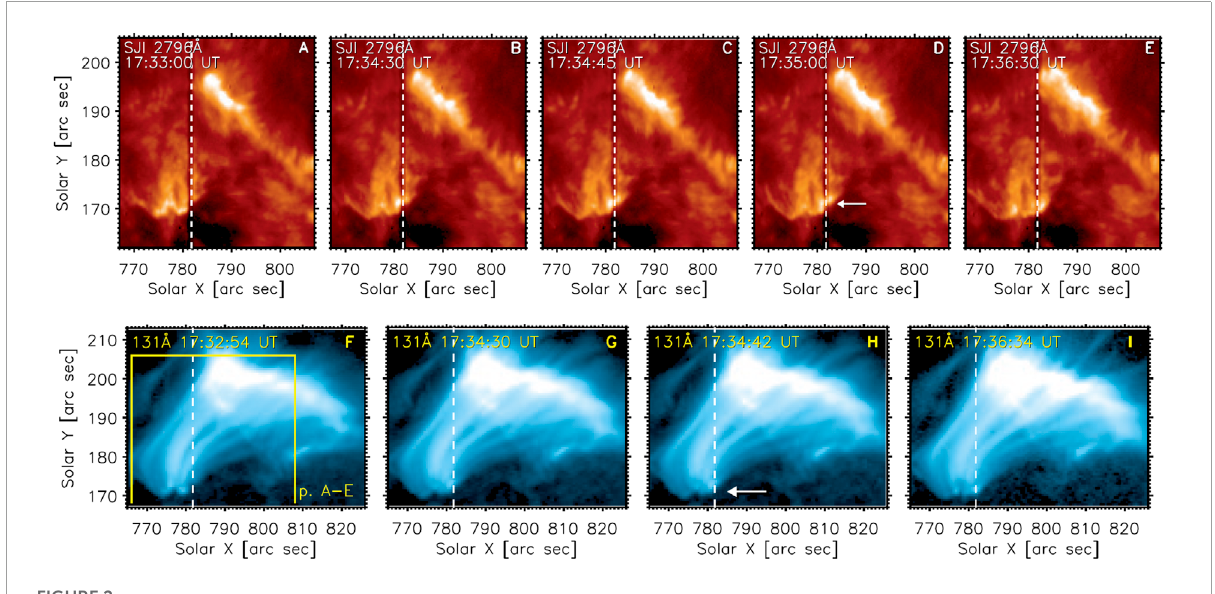
FIGURE 2 A pair of flare ribbons [panels (A–E) ] and an arcade flare loops [panels (F–I) ] observed in the SJI 2796Å and AIA 131Å during the impulsive phase of the flare. White dashed line marks the position of the IRIS slit at 17:35 UT. The white arrow plotted in panels (D) and (H) points to kernels (top row), resp. flare loop footpoints (bottom row) which spectra are analyzed in this manuscript. Animated version of the SJI observations is available online. The animation covers the period between 17:30 and 17:40